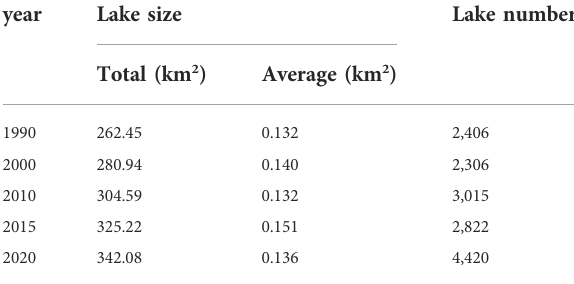
TABLE 1 Lake size and number variation in different